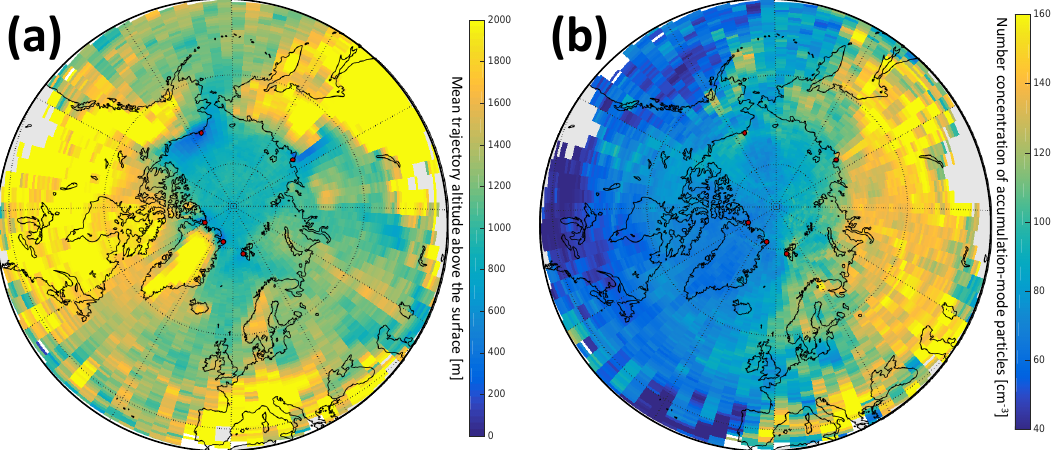
Figure 9. Like Fig. 8, but the maps presents the combined the data for all sites together. Panel (a) displays the mean trajectory height above the surface, and panel (b) shows the mean concentration of accumulation-mode particles. The locations of the sites are denoted by the small red